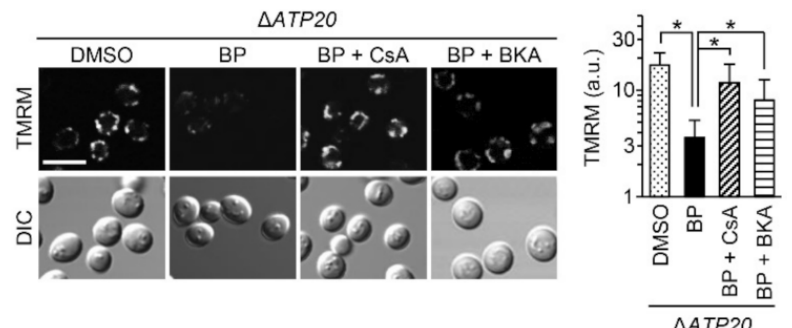
Figure 4. The effect of BP, with or without CsA or bongkrekate (BKA), on the mitochondrial mem- brane potential in ∆ ATP20 , a mutant strain with defective dimerization of ATP synthase. The effect of BP on its parental strain (BY4743) is shown in Figure 3. TMRM fluorescence images at 4 h (left panel) and quantification (right panel) (data represent the mean ± SD from 100–150 cells; * p < 0.001). Scale Bar: 5 µ m.